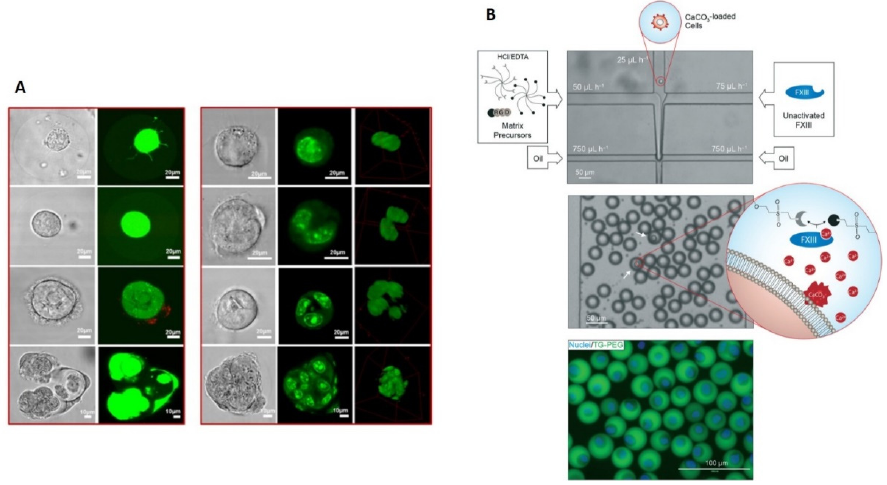
Figure 2. ( A ) Representative confocal microscopic images of cell growth of single MSCs within microgels. Live and dead cells were stained with Calcein and Ethidium Homodimer whereas alginate was labelled by the fluorescein. Reprinted from Ref. [53], Copyright 2020, with permission from Elsevier. ( B ) Single cell-laden 3D microgels mimicking stem cell niches in vitro (microniches) fabricated by droplet-based microfluidics. Matrix precursors, a diluted solution of cells loaded with CaCO 3 nanoparticles, and unactivated Factor XIII (FXIII) are separately injected into a microfluidic chip. Reagents are joined in a laminar flow resulting in an emulsion for hydrogel formation. Cells, encapsulated in FITC labelled microniches, were stained with Hoechst 33342. Republished with permission of Royal Society of Chemistry, from Ref. [16]; permission conveyed through Copyright Clearance Center, Inc. Ref. Table 2. Major developments on microgel-based 3D cell culture at single cell level.